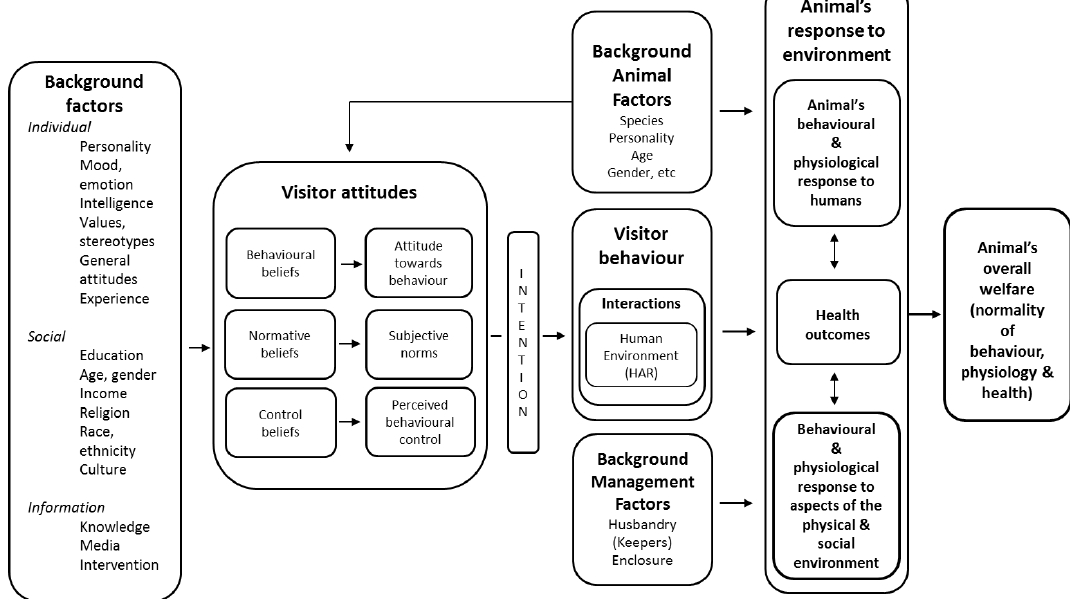
Figure 1. Proposed visitor-animal interaction model (adapted from Hemsworth-Coleman model (2011) by S. Chiew and L. Hemsworth, pers. comms. , 2016)